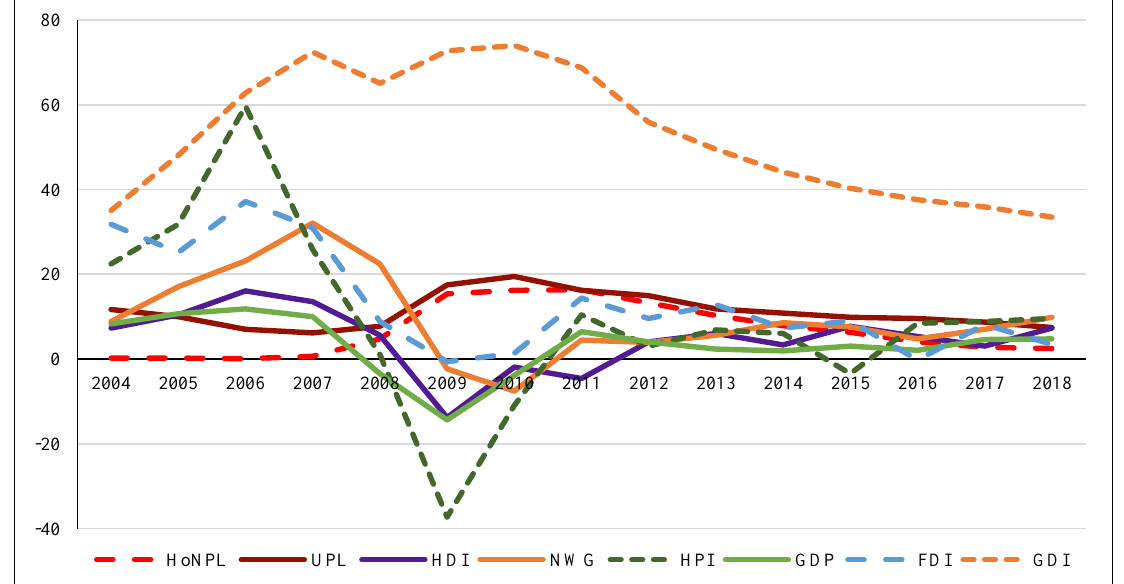
Figure 2. Macro indicators and HoNPL (Eurostat, BoL, FCMC, CSB of Latvia data).